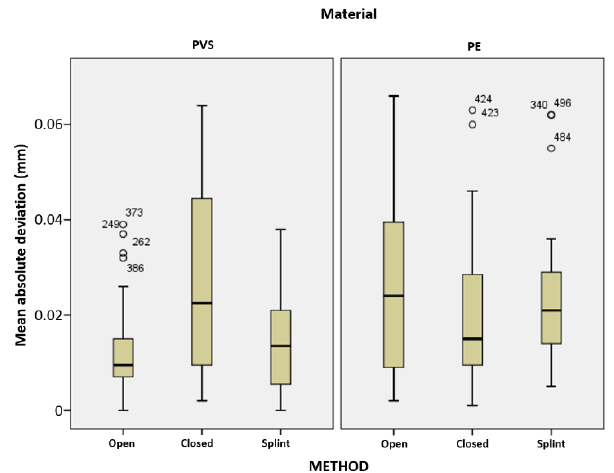
Figure 17. Graphical representation of the distribution of mean absolute deviations for the tooth abutments according to the method and material used.